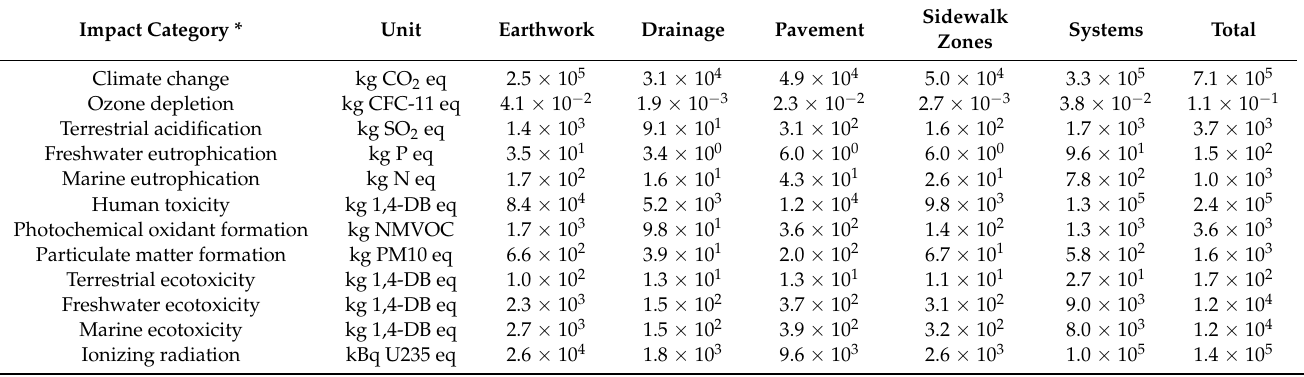
Table 6. Road life cycle impact analysis